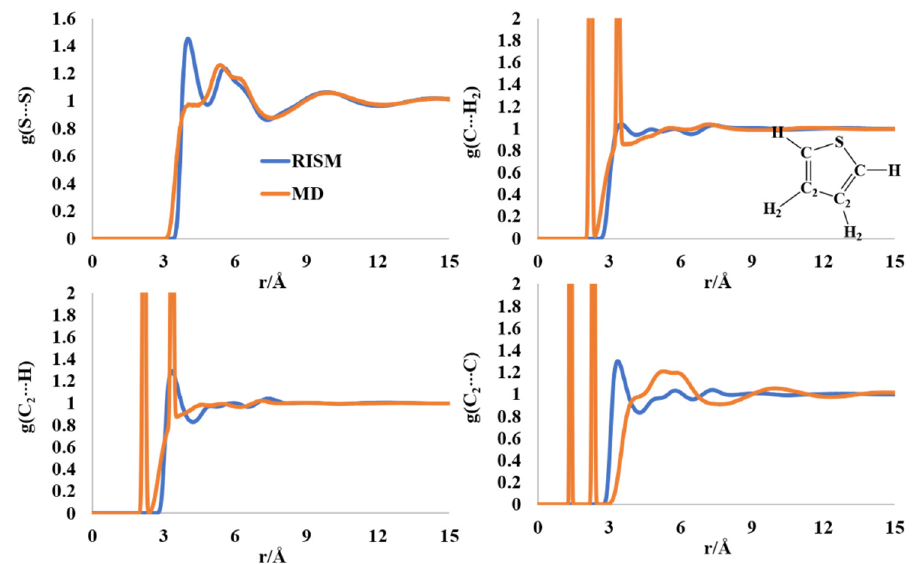
Figure 4. RISM- and MD-computed distribution functions for liquid thiophene.